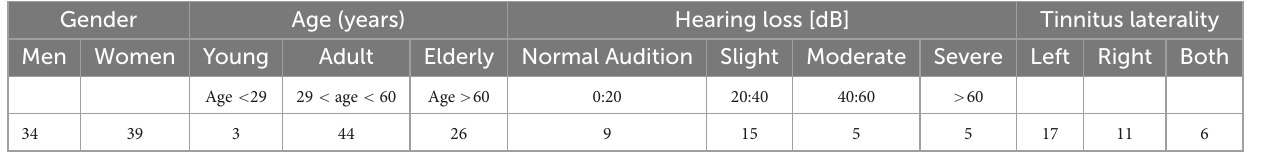
TABLE 3 Clinical and demographic information of the tinnitus sufferers recruited for this study. Gender Age (years) Hearing loss